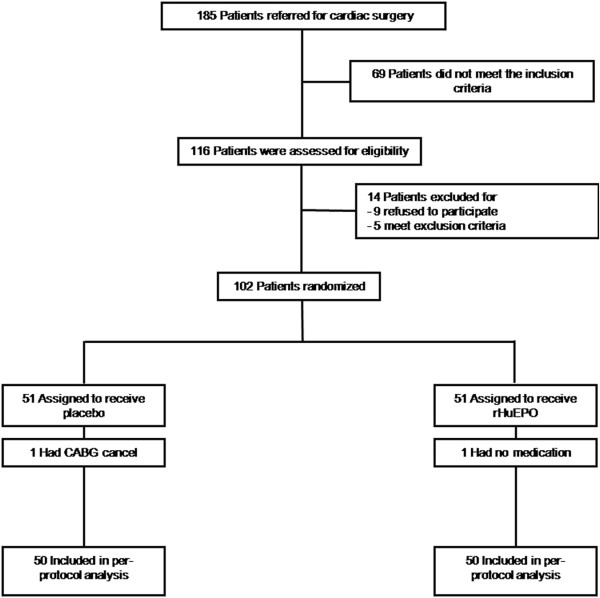
Flow diagram on enrollment of patients into the study.